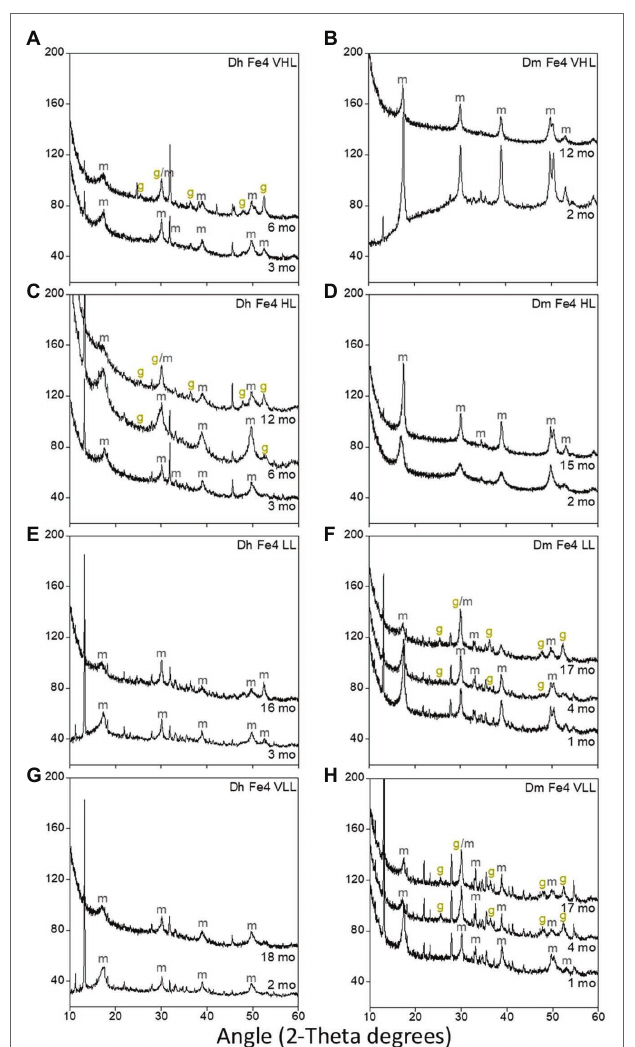
FIGURE 4 | X -ray diffraction (XRD) spectra of biogenic minerals precipitated in cultures of Dh AM13 (A,C,E,G) and in cultures of Dm RS-1 (B,D,F,H) . Only the peaks relevant to iron sulfide minerals have been labeled ( m , mackinawite; g, greigite). Other peaks visible on theses spectra are form vivianite [Fe(II) phosphate